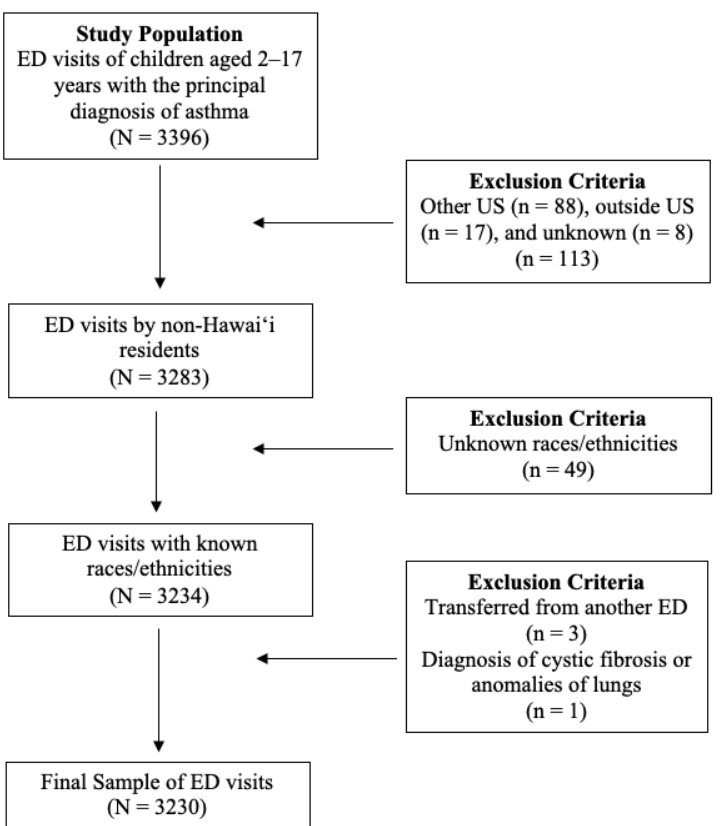
Figure 1. Flowchart of Exclusion Criteria.